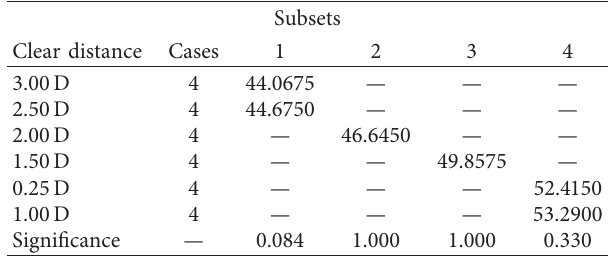
Table 5: Significance analysis of the tunnel clear distance.